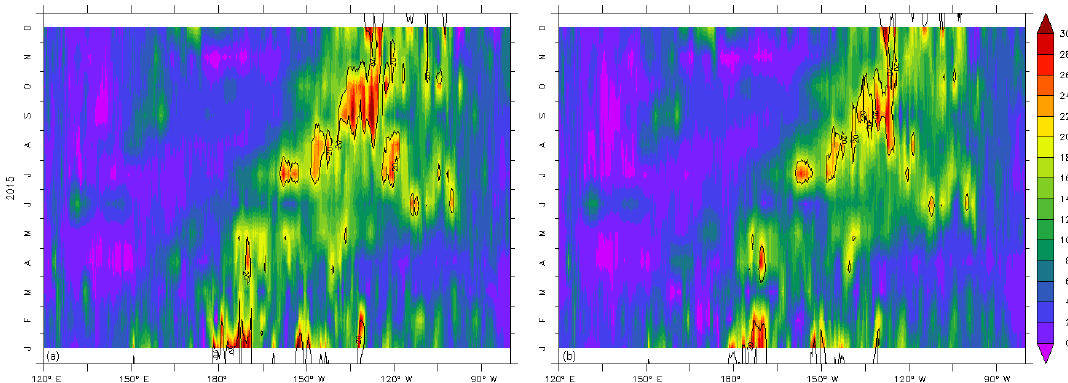
Figure 13. Hovmöller diagram of barrier layer thickness (BLT) at 5 ◦ N for the REF experiment in (a) and for the SMOSexp (b) experiment in 2015.